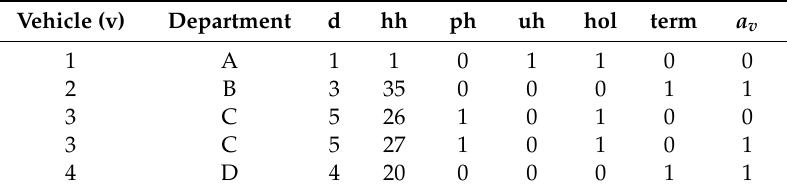
Table 2. Sample data from the processed dataset.